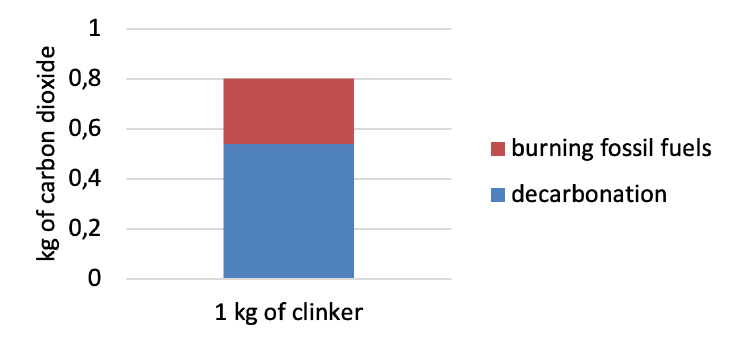
Figure 1. Carbon footprint of 1kg of clinker.